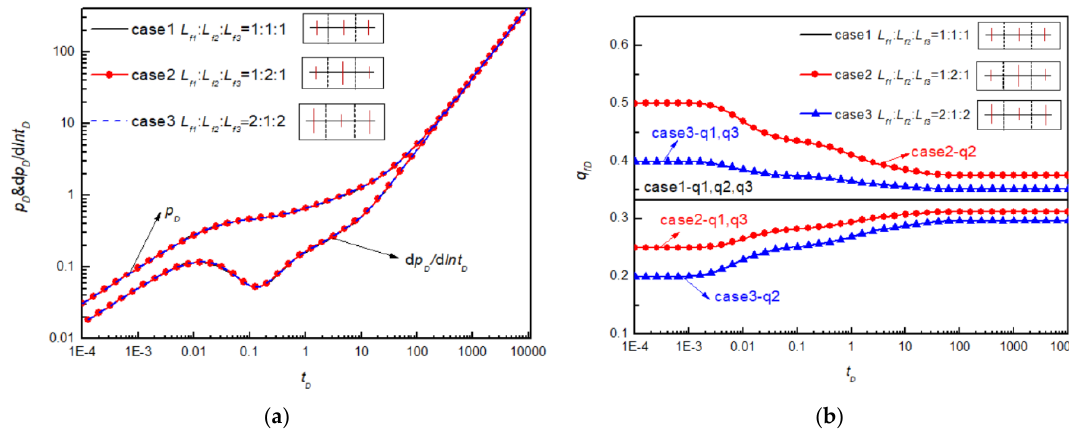
Figure 9. Pressure response and flux distribution of different half-length distribution. ( a ) Pressure and pressure derivative; ( b ) Flux distribution of each hydraulic fracture.